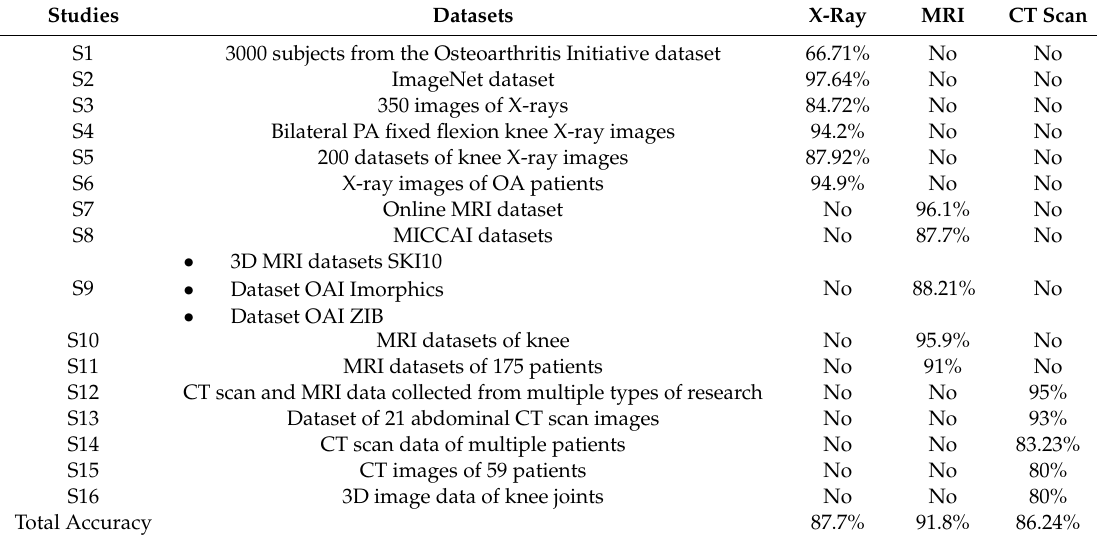
Table 17. Accuracy of deep learning papers.